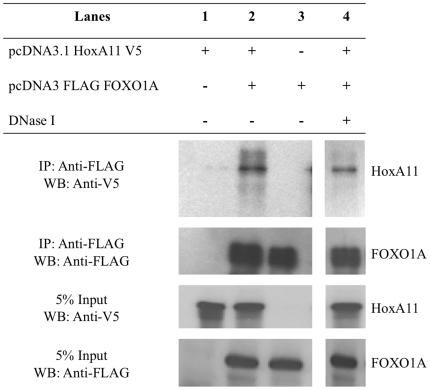
Physical interaction between HoxA-11 and FOXO1A.HoxA-11-V5/His and Flag-FOXO1A were overexpressed in HeLa cells and subjected to co-immunoprecipitation with anti-FLAG agarose beads. Eluates, without or with DNase treatment, were analyzed by Western blotting with V5 antibody, followed by re-probing with FLAG antibody.